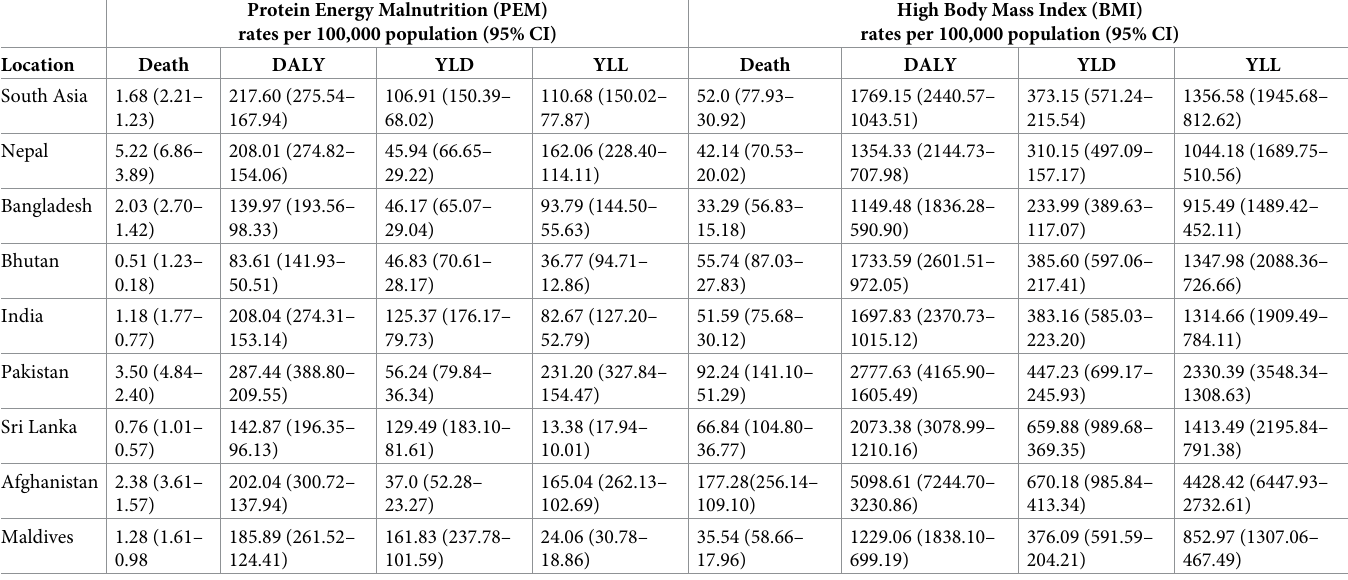
Table 1. DALY, YLL, YLD, Death for PEM and High BMI among South Asian countries (2019). Protein Energy Malnutrition (PEM) rates per 100,000 population (95% CI)